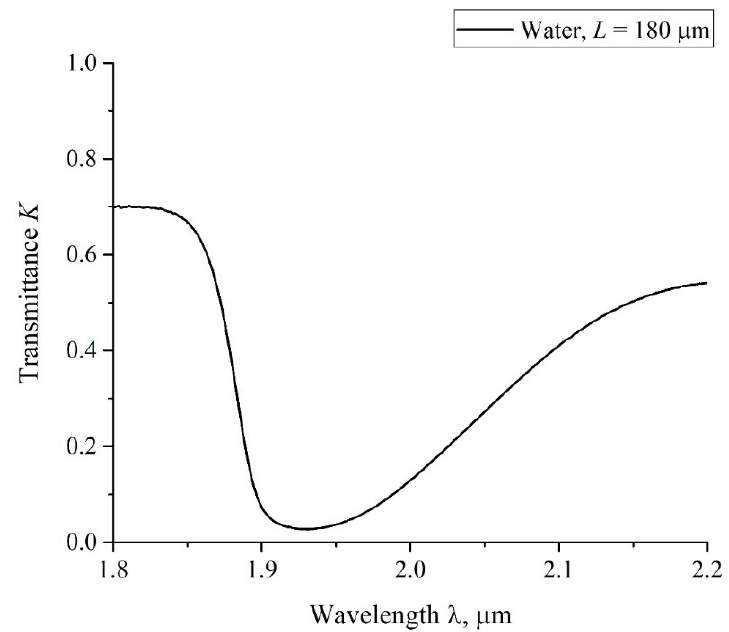
Figure 3. The spectrum K for water in the spectral range 1.8 < λ < 2.2 μ m; L = 180 μ m.